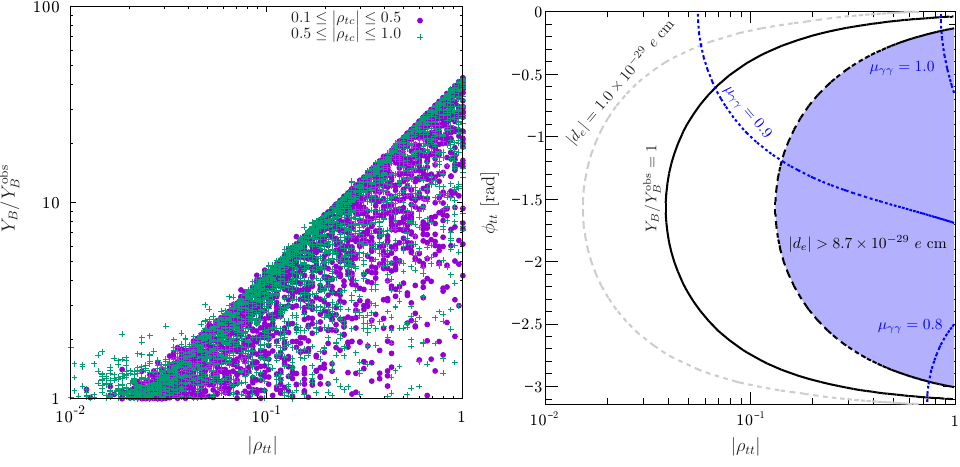
[ 0,2 π ] , and purple (green) ∈ d e ρ tt in the - φ tt plane, where the | | | | , and the gray dashed curve is B